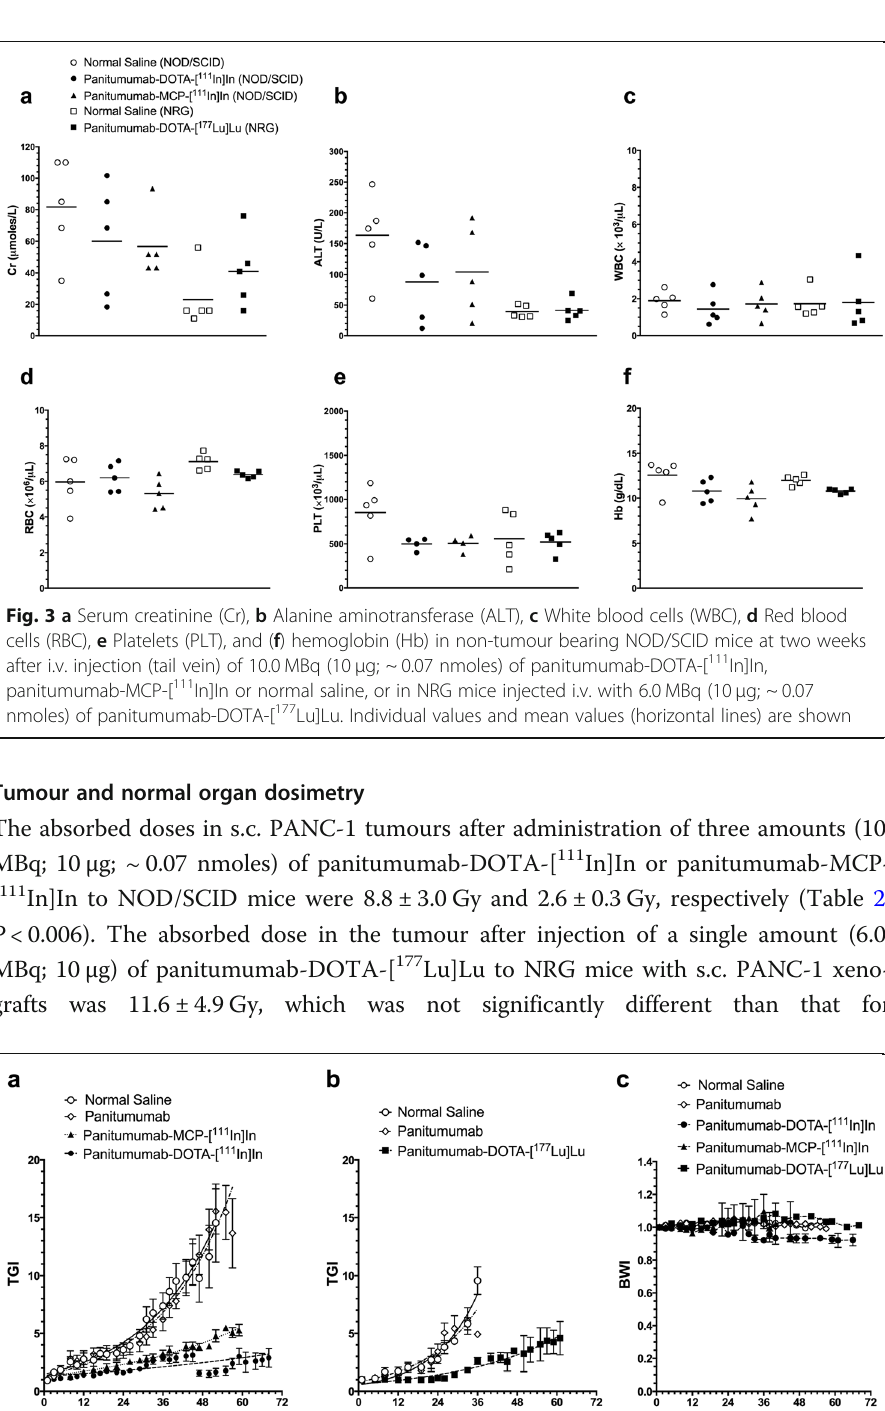
Fig. 4 Tumour growth index (TGI) vs. time (days) in ( a ) NOD/SCID mice with s.c. PANC-1 xenografts treated with three i.v. (tail vein) injections (10 MBq; 10 μ g; ~ 0.07 nmoles) of panitumumab-MCP- 111 In, panitumumab-DOTA- 111 In or unlabeled panitumumab (10 μ g; ~ 0.07 nmoles) or normal saline separated by 3 weeks or in ( b ) NRG mice with s.c. PANC-1 xenografts treated with a single i.v. injection (10 MBq; 10 μ g; ~ 0.07 nmoles) of panitumumab-DOTA- 177 Lu or unlabeled panitumumab (10 μ g; ~ 0.07 nmoles) or normal saline. The TGI vs. time curves were fitted to an exponential growth model (lines) to estimate tumour doubling times. The body weight index (BWI) is shown in ( c ) for tumour-bearing NOD/SCID and NRG mice treated with the RICs, unlabeled panitumumab or normal saline